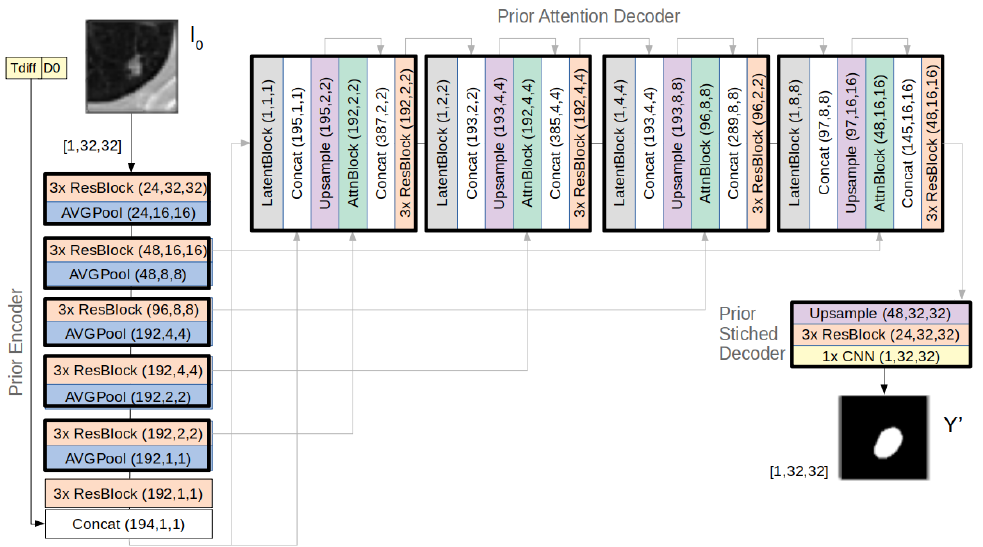
Figure 3. Architecture details of the prior subnet of the U-HPNet (the posterior subnet follows the same architecture, but also receives I 1 as